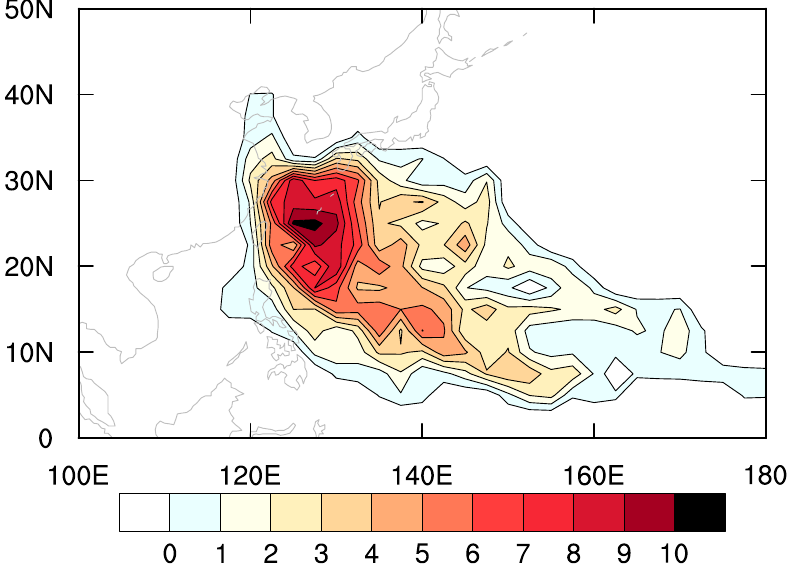
Figure 1. Seasonal mean occurrence frequencies of tropical cyclones (TCs) affecting South Korea from their genesis to 300 km away from the coastlines of South Korea. The unit is